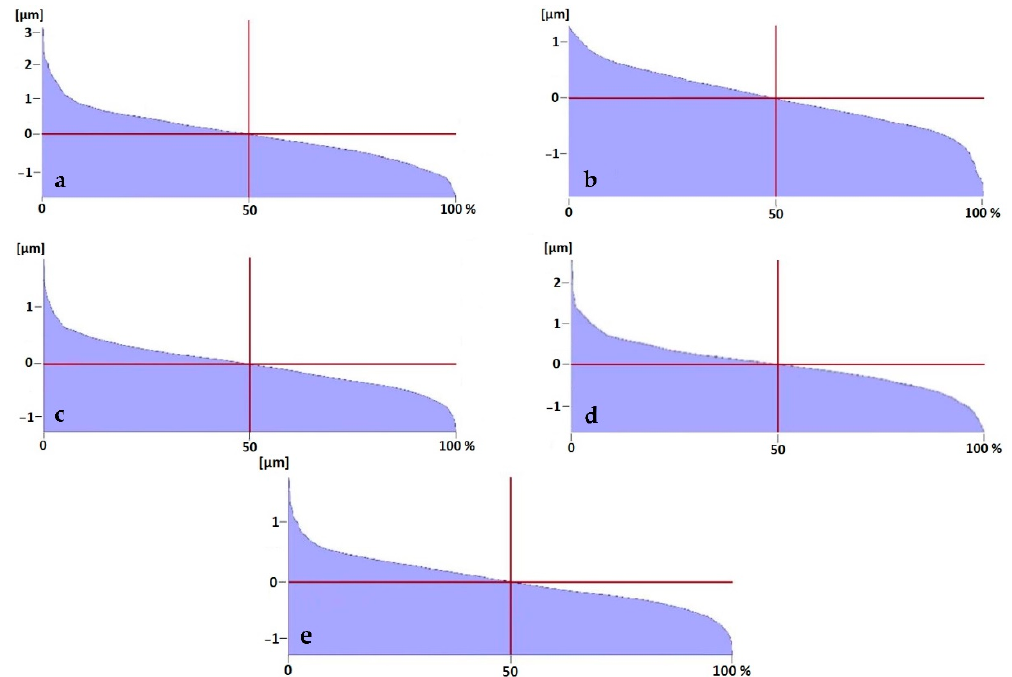
Figure 8. Bearing area curves for the surfaces processed with the T1–T5 tools with feed f 3 = 0.3 mm/rev.: ( a ): T1; ( b ): T2; ( c ): T3; ( d ): T4; ( e ): T5.